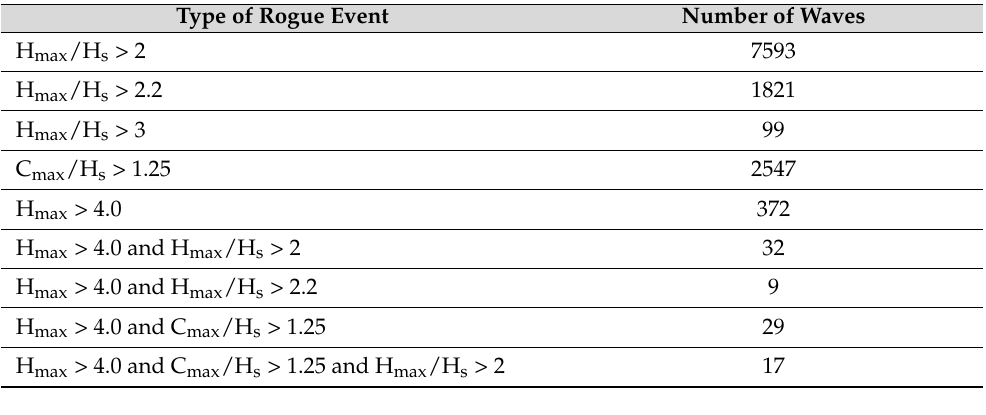
Table 1. The different definitions of rogue wave events and the number of waves that met those criteria that were found in the dataset recorded by the CDIP Waverider buoy near Egmont Key in 2015–2019. H max is the measured maximum wave height (from maximum surface elevation), H s is the significant wave height and C max is the maximum crest height.